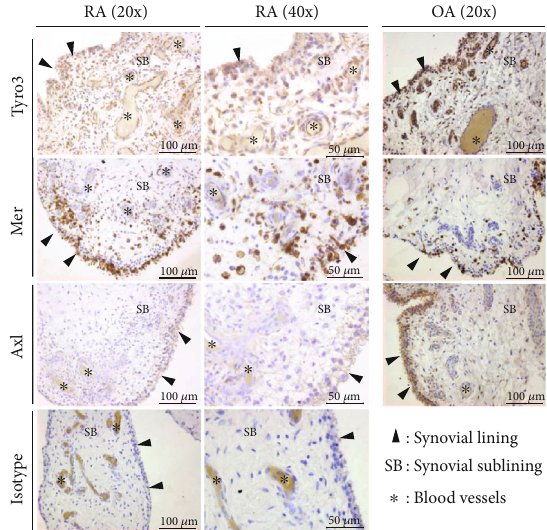
Figure 1: Immunohistochemistry of TAM receptors in the human synovium from rheumatoid arthritis and osteoarthritis patients. Synovial biopsies from rheumatoid arthritis (RA) ( n = 2 ) and osteoarthritis (OA) ( n = 8 ) patients were processed for immunohistochemical staining of Tyro3, Mer, Axl, and IgG isotype control. Sections were counterstained with hematoxylin. Pictures were taken at 20x and 40x magni fi